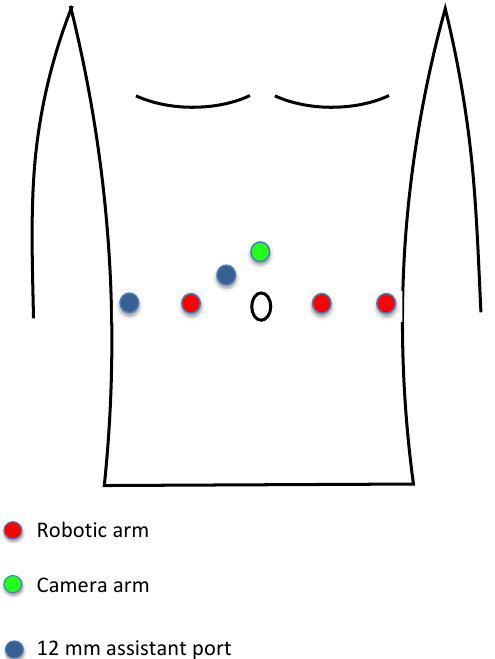
Figure 1. Port positioning during robotic assisted radical cystectomy.